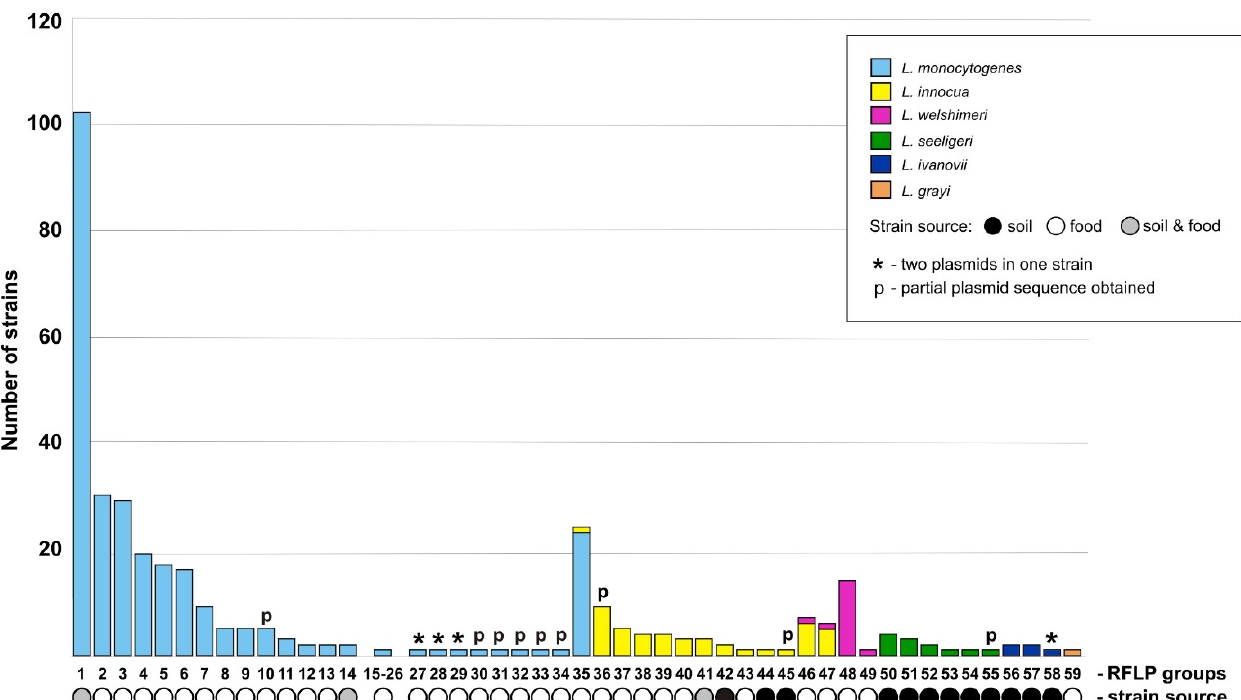
Figure 1. Classification of Listeria spp. plasmids identified in our studies according to their restriction fragment length polymorphism (RFLP) profiles, arranged by species and in descending order of the number of strains with identical plasmid profiles.